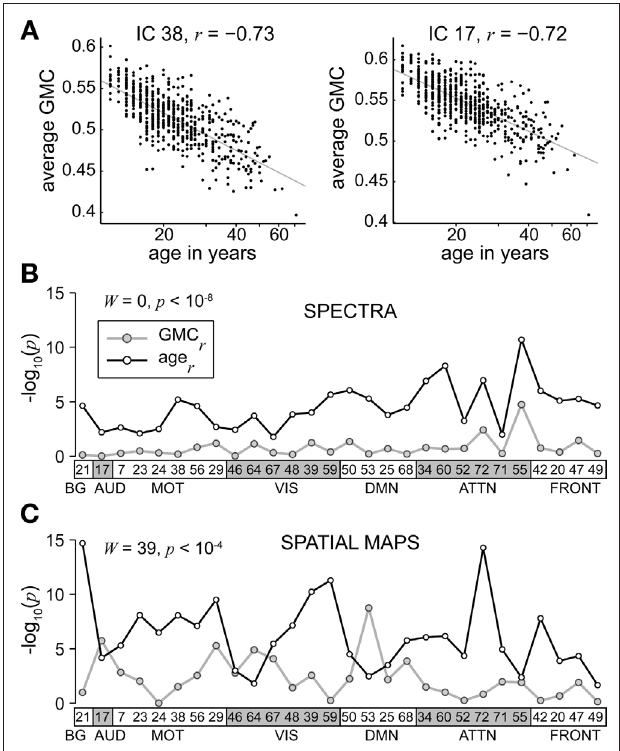
Figure A2 | evaluation of age and gray matter concentration as predictors. (A) Typical examples of the relationship between log(age) and GMC (averaged over voxels in the thresholded SM). (B,C) Significance of the residualized GMC (GMC , gray) and residualized log(age; age , black) terms in r r models predicting spectral power (B) and SM intensity (C) for each RSN. Wilcoxon signed-rank statistics ( W ), based on the difference between − log ( p ) 10 values, are displayed on each plot.